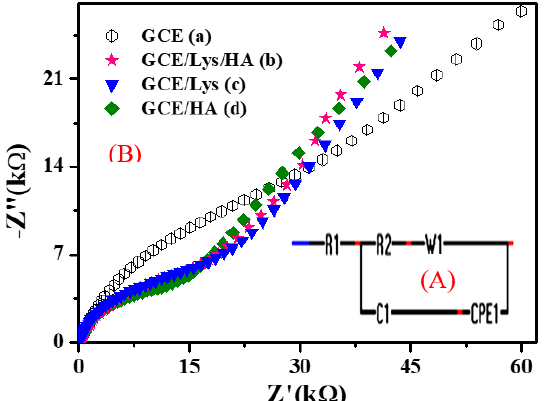
Figure 4. Nyquist EIS curves obtained on (A) the equivalent circuit; (B) (a) GCE, (b) GCE/Lys/HA, (c) GCE/Lys and (d) GCE/HA in a 0.1 M NaCl solution containing 10 − 3 M [Fe(CN) 6 ] 3−/4− .